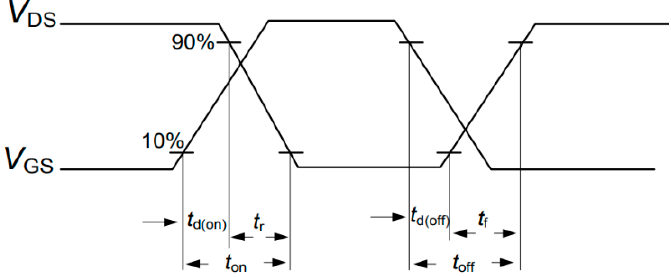
Figure 15. Interpretation of the identification of turn-on and turn-off times based on switching waveforms.